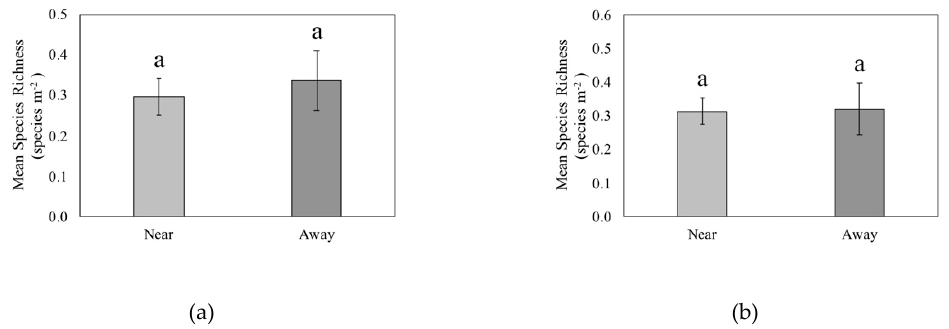
Figure 4. Mean species richness of ( a ) seedlings (live woody stems < 1 m height) and ( b ) saplings (live woody stems ≥ 1 m height, < 5 cm dbh) by quadrats located near and away from coarse woody debris (CWD) in a Pinus palustris woodland following catastrophic disturbance. No significant differences ( p < 0.05) were found.